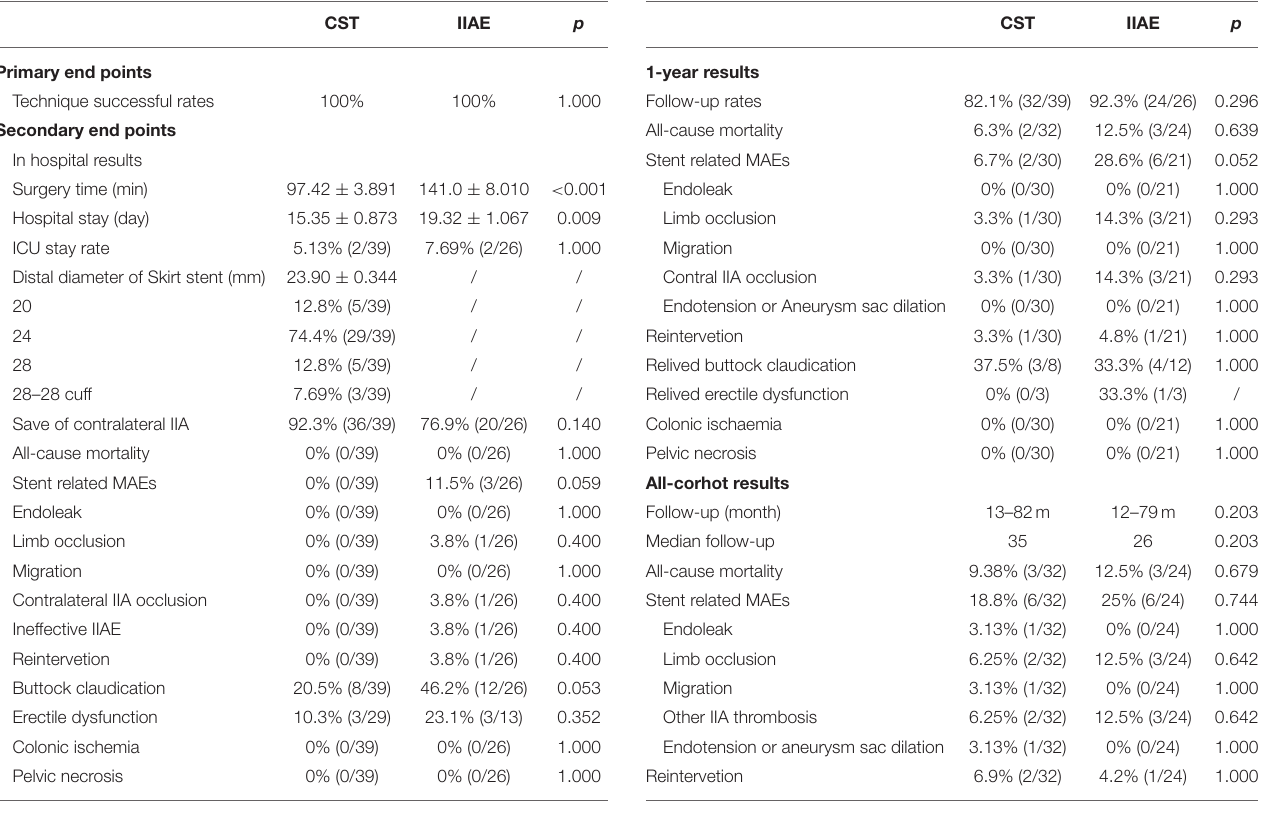
TABLE 2 | Procedure and in-hospital